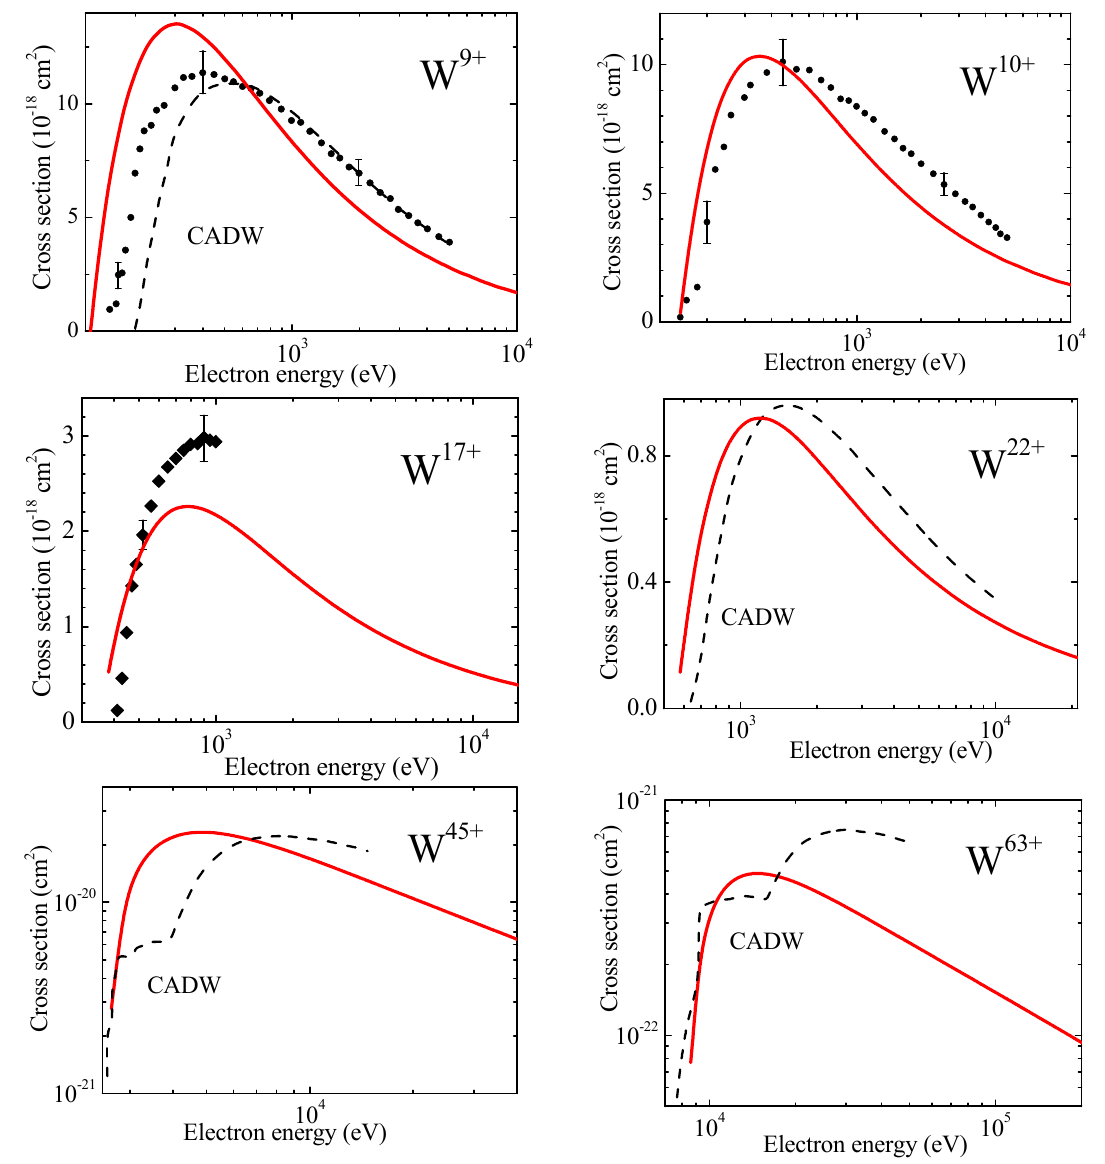
Figure 7. Comparison of theoretical electron impact ionization cross-sections with experimental data for ions W k + with k = 1,2,...10,17,22,45,63: solid curves—present statistical model; black points—[21]; open triangles—[22]; full triangles—CADW data [23]; open circles [24]; full squares—[25]; dashed curves signed